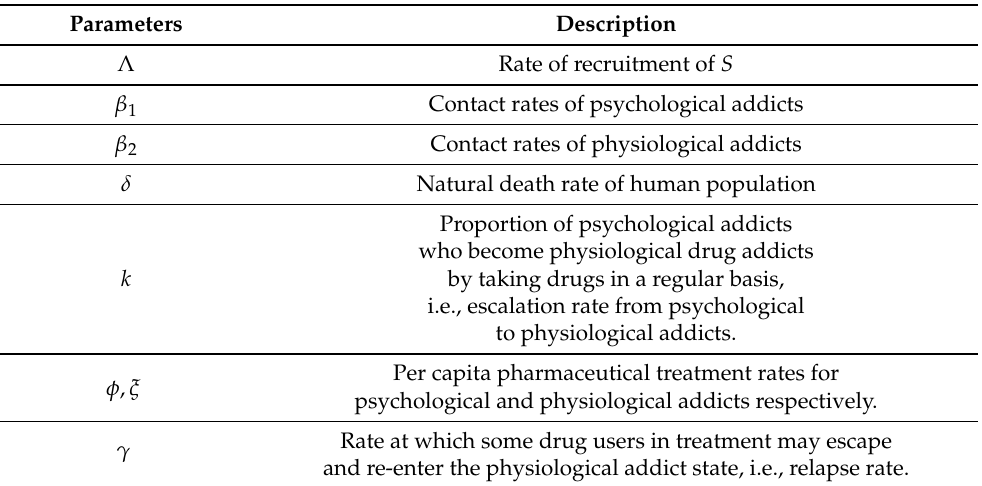
Table 1. Parameters of system